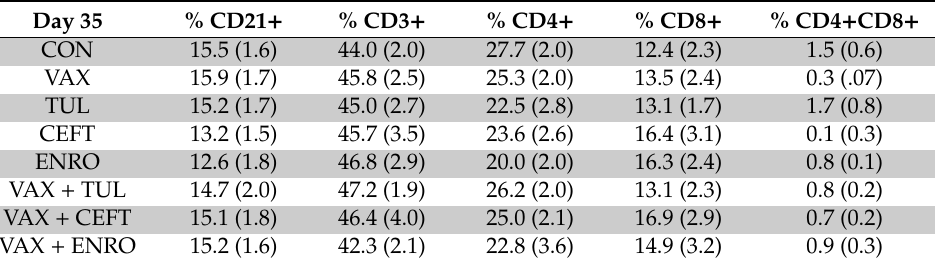
Table 2. The percentage of lymphocyte subsets at day 35. The percentage of lymphocyte subsets in peripheral blood was assessed by flow cytometry. The mean and SEM (parentheses) were recorded for each lymphocyte subset. There was no di ff erence in immune cell percentages between treatment groups. Additionally, there was no di ff erence between groups at days 0, 14, 21 (not shown). Day 35 % CD21